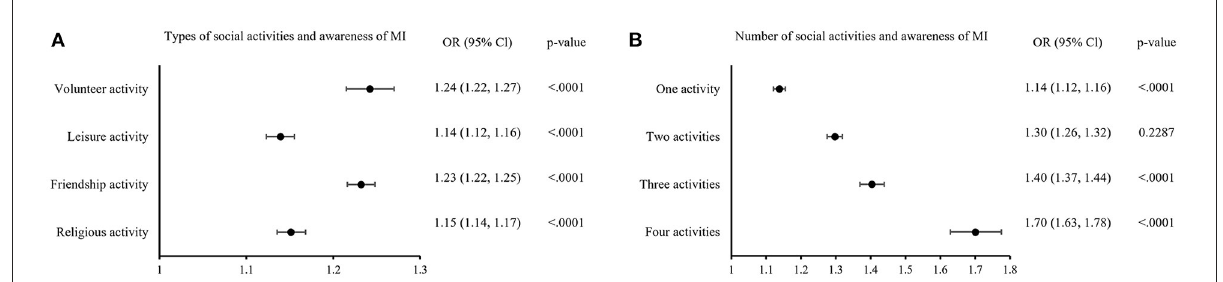
FIGURE2 Subgroup analysis of social activities and awareness of warning symptoms of MI. (A) Shows the odds of having awareness in individuals who participate in each types of social activities compared to who do not. (B) Shows the odds of having awareness depending on the number of social activities. Odds ratio were adjusted for sex, age, region, marital status, household type, monthly household income, highest level of education, occupation, smoking, drinking, hypertension, diabetes, and examination